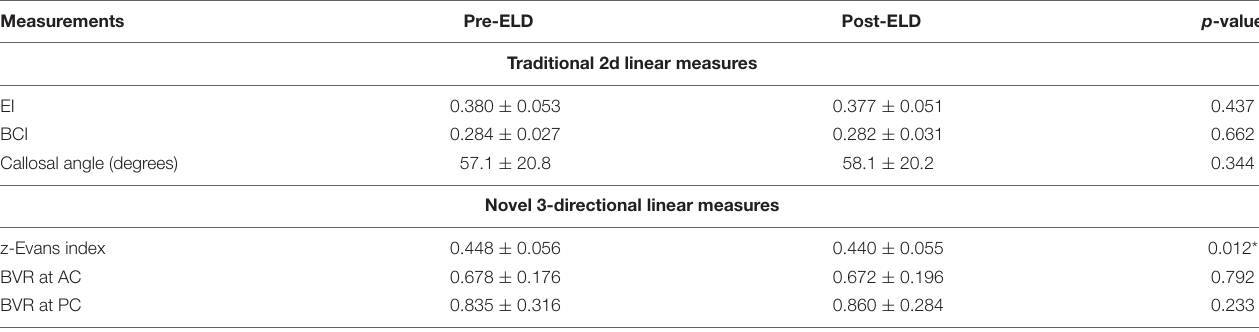
TABLE 5 | Comparison of normal pressure hydrocephalus (NPH) cohorts pre- and post-lumbar testing using morphological measures, regardless of responsiveness to external lumbar drainage (ELD). Measurements